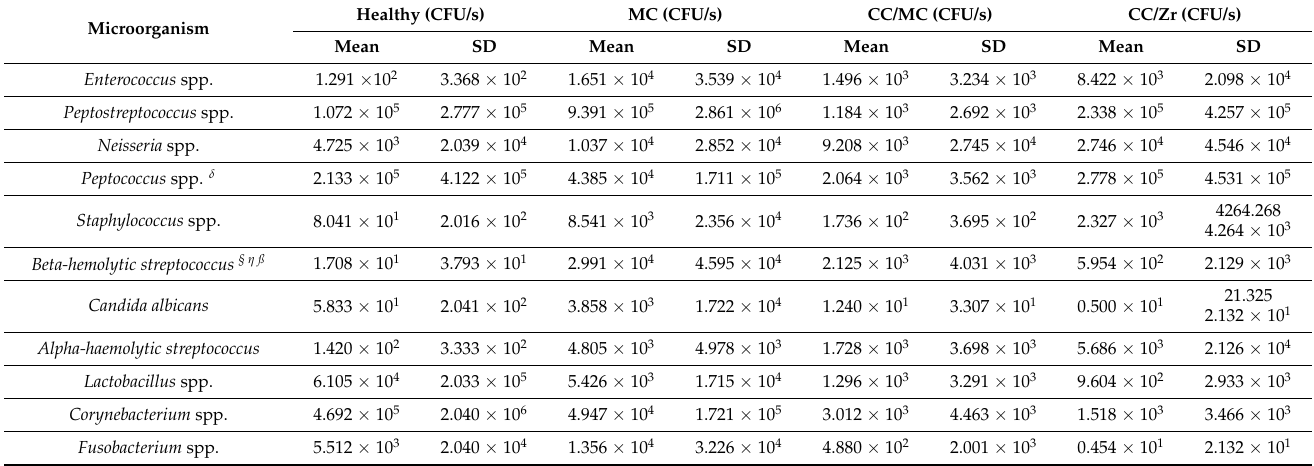
The multiple comparisons of microbiological compositions and counts of the GCF showed that Beta-hemolytic streptococcus significantly differed between the healthy vs. MC ( p = 0.025) and between the MC vs. CC-MC groups ( p = 0.024) (Table S2). The microbiologic compositions of the GCF in all groups at 12 months of prosthetic treatment are presented in Table 4. Peptococcus spp. was observed in greater numbers in the healthy, MC, and CC-Zr groups. It was shown that the number of microorganisms dramatically reduced in all the groups compared with the data obtained before prosthetic treatment. Moreover, C. anaerobium was absent in the healthy group after one year of prosthetic treatment. Table 4. Microbiologic composition and counts of the GCF in all groups at 12 months of treatment.